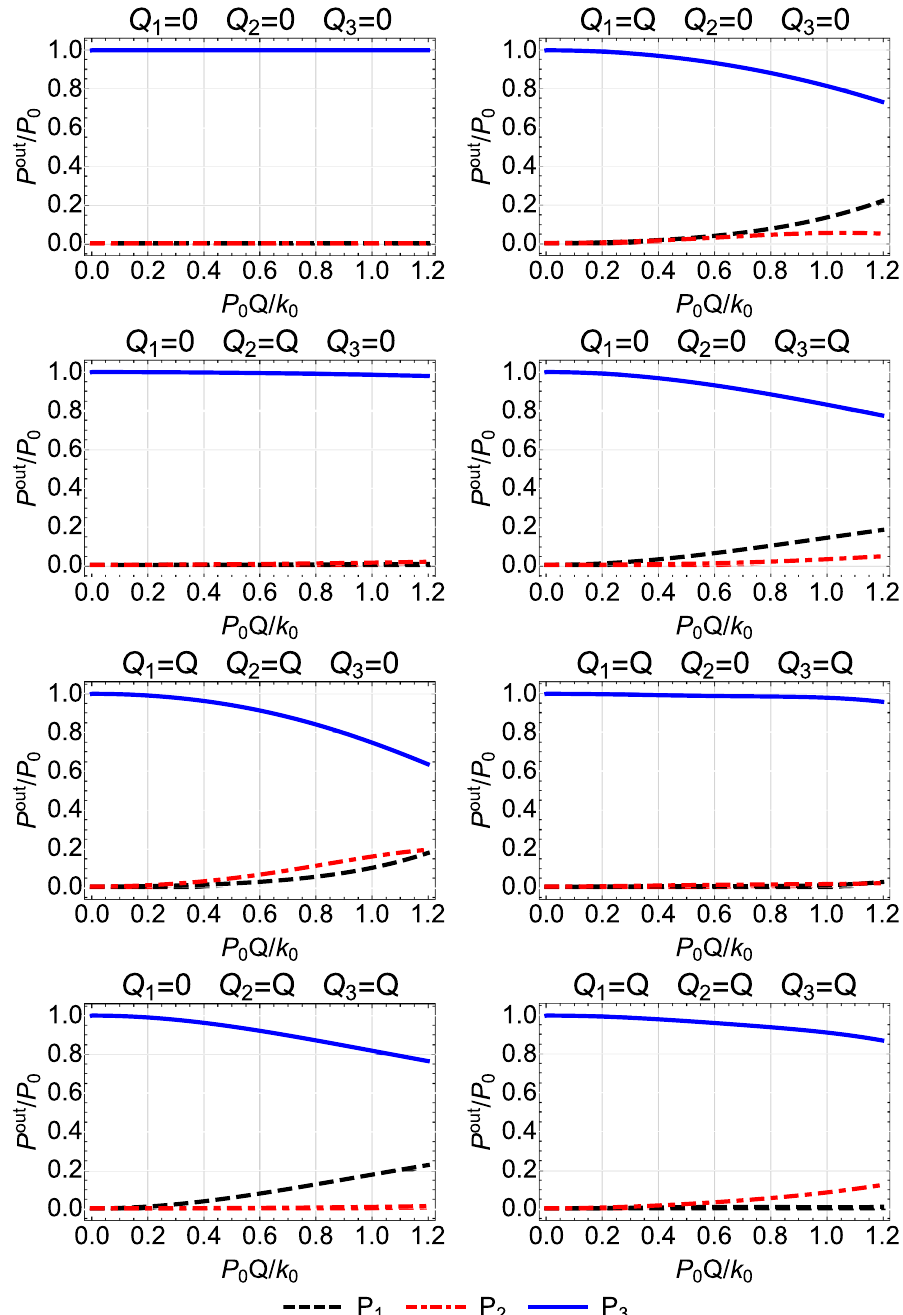
out P P i ( Z )/ P 0 0 at each waveguide as a function of the normalized i / =